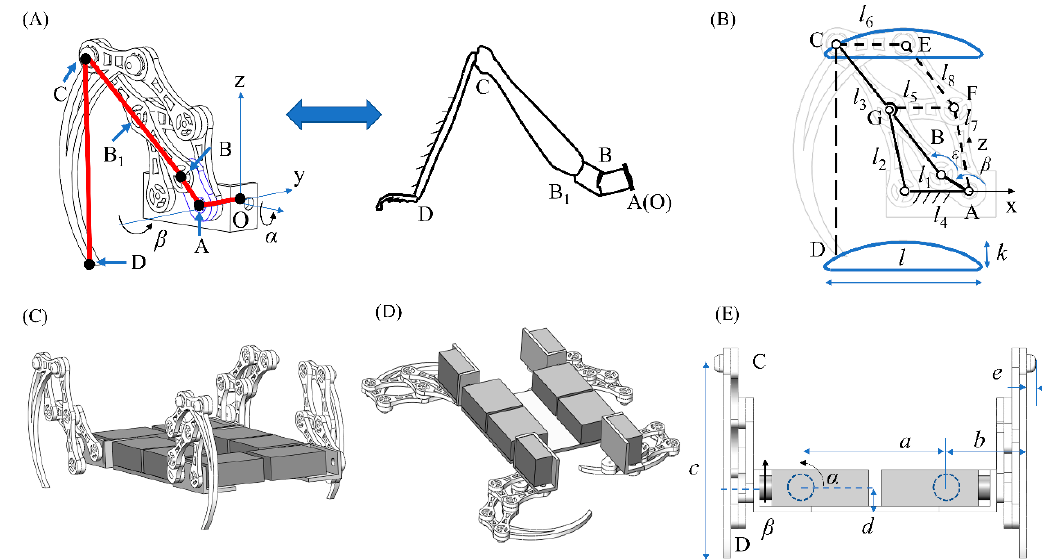
Figure 2. Model diagram of the robot structure. ( A ) Multi-link leg structure inspired by insects; ( B ) kinematics parameters of the leg; ( C ) climbing robot with effective contact by point D (tarsus); ( D ) climbing robot with effective contact by point C (tibia); ( E ) the front view of the robot and main structure size parameters.